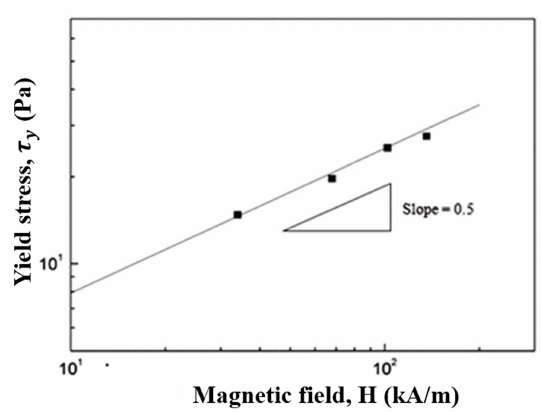
Figure 16. Dynamic yield stress of Fe 3 O 4 / PPy based MR fluid (10 vol %) as a function of magnetic field strength on a log-log scale (Park et al. [97], © The Royal Society of Chemistry, 2015).